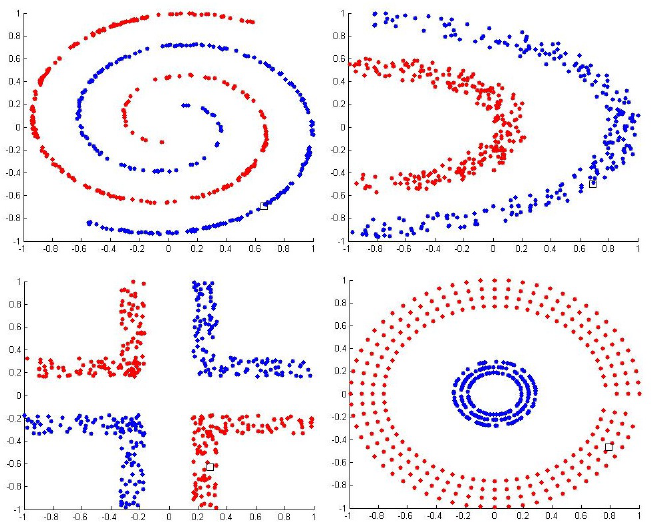
Figure 2. Bases of Delaunay triangulation.